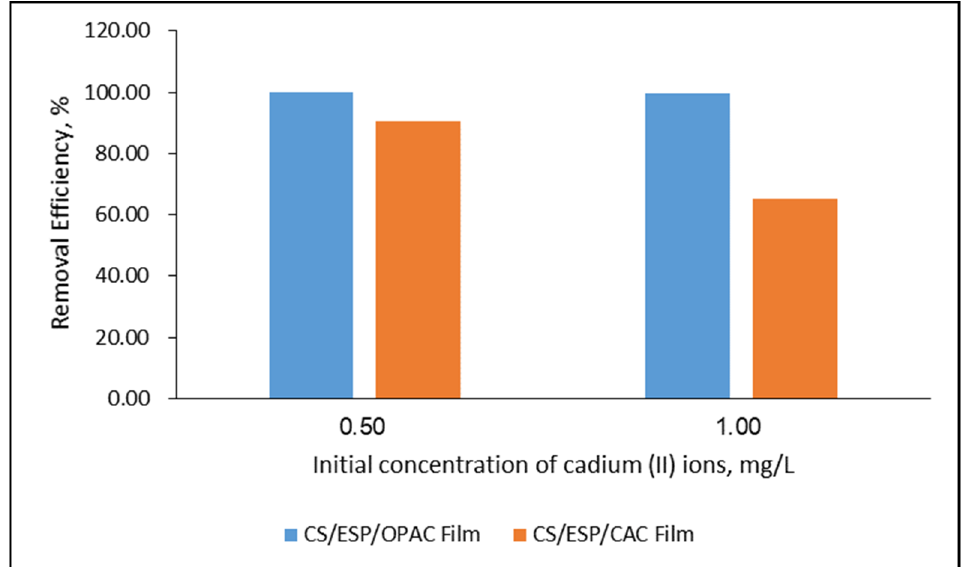
Figure 6. Effects of initial Cd 2+ ion removal efficiency of CS/ESP/ACOP film and CS/ESP/CAC film (Experimental Condition: pH 5, 24 h, 250 rpm, 25 ° C ).